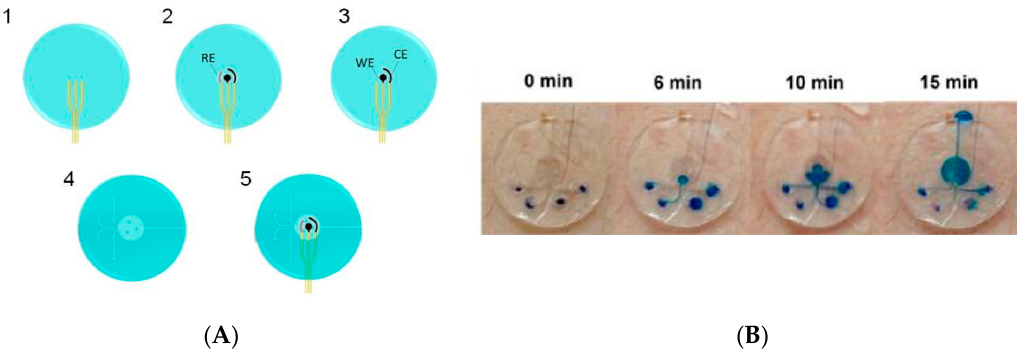
Figure 7. ( A ) Microfluidic electrochemical patch with (1) Gold current collectors lithographied then transferred on the PDMS substrate; (2,3) Reference (RE) screen-printed with silver/silver chloride (Ag/AgCl), working (WE) and counter (CE) electrodes screen-printed with Prussian blue; (4) PDMS microfluidic layer finally bonded (5) on top of the PDMS electrode layer. ( B ) View of the complete patch glued on skin, as a function of time during effort. Sweat is mixed with a blue dye inside the device for this picture. Reproduced from [34] with permission. Copyright © 2017, American Chemical Society.